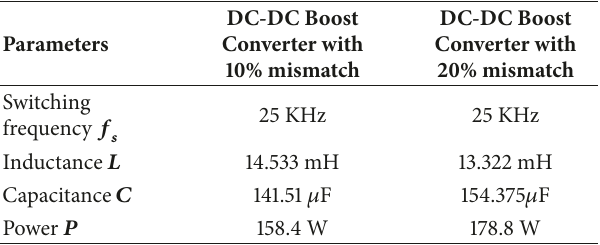
Table 3: Operating values for boost